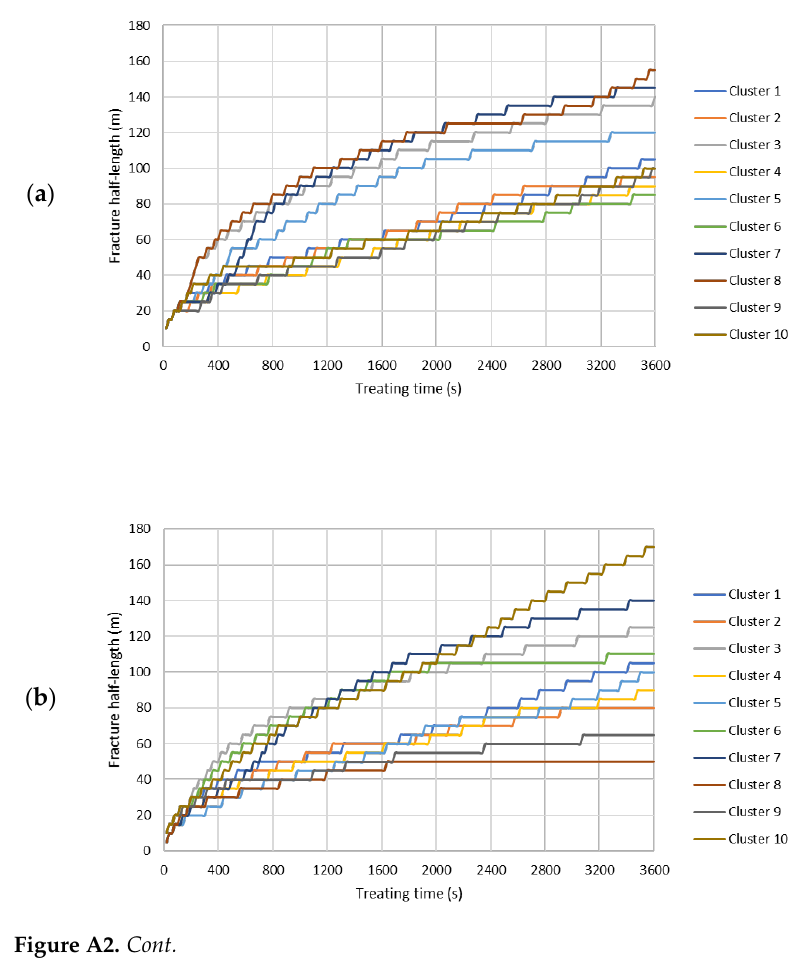
Figure A2. Fracture half-length of each cluster during the hydraulic fracturing treatment. ( a ) Slick water case. ( b ) NG foam case. ( c ) Hybrid NG/NG foam case.